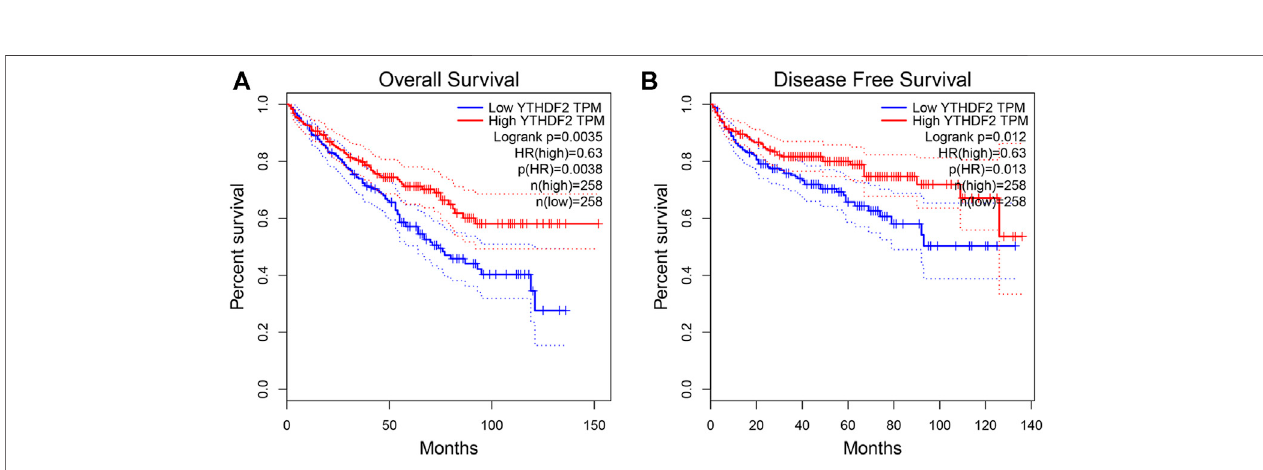
FIGURE 3 | The prognostic value of YTHDF2 in KIRC. (A) The disease-free survival in KIRC patients with high or low YTHDF2 expression (GEPIA2). (B) The overall survival in KIRC patients with high or low expression of YTHDF2 (GEPIA2). KIRC, Kidney renal clear cell carcinoma. KIRC, Kidney renal clear cell carcinoma.